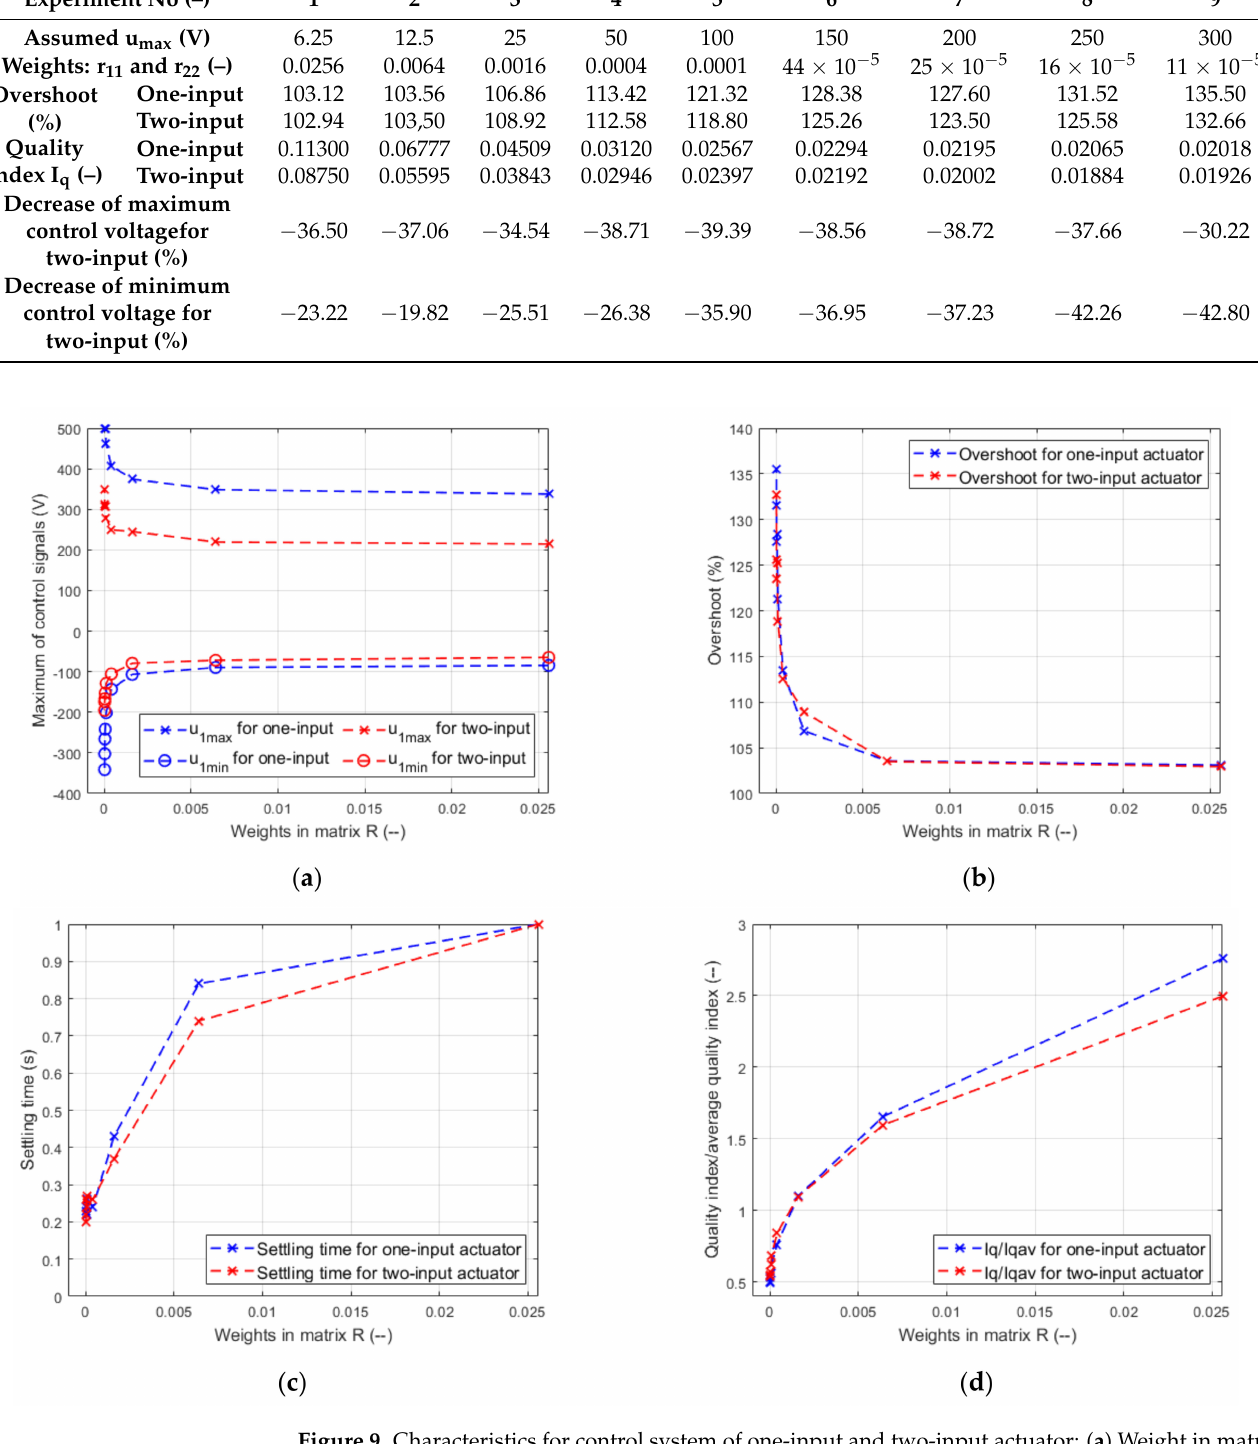
Figure 9. Characteristics for control system of one-input and two-input actuator: ( a ) Weight in matrix R versus maximum control voltage u 1 ; ( b ) Weight in matrix R versus overshoot; ( c ) Weight in matrix R versus settling time; ( d ) Weight in matrix R versus normalized quality